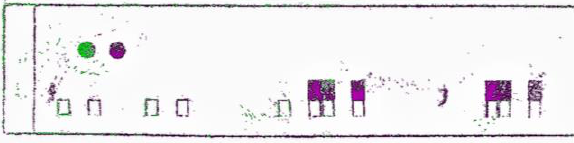
Figure 11. View of horizontal section for BLK2GO clouds (path1vs. path 2)